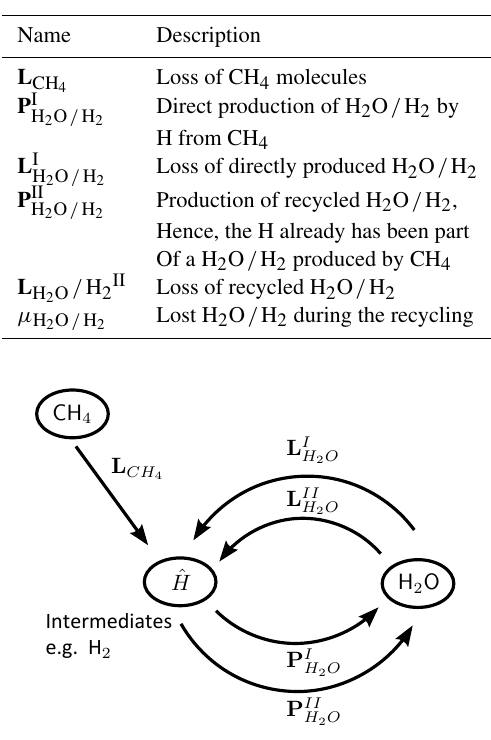
Table 1. Variable names as used in Eqs. (2), (3) and (4).